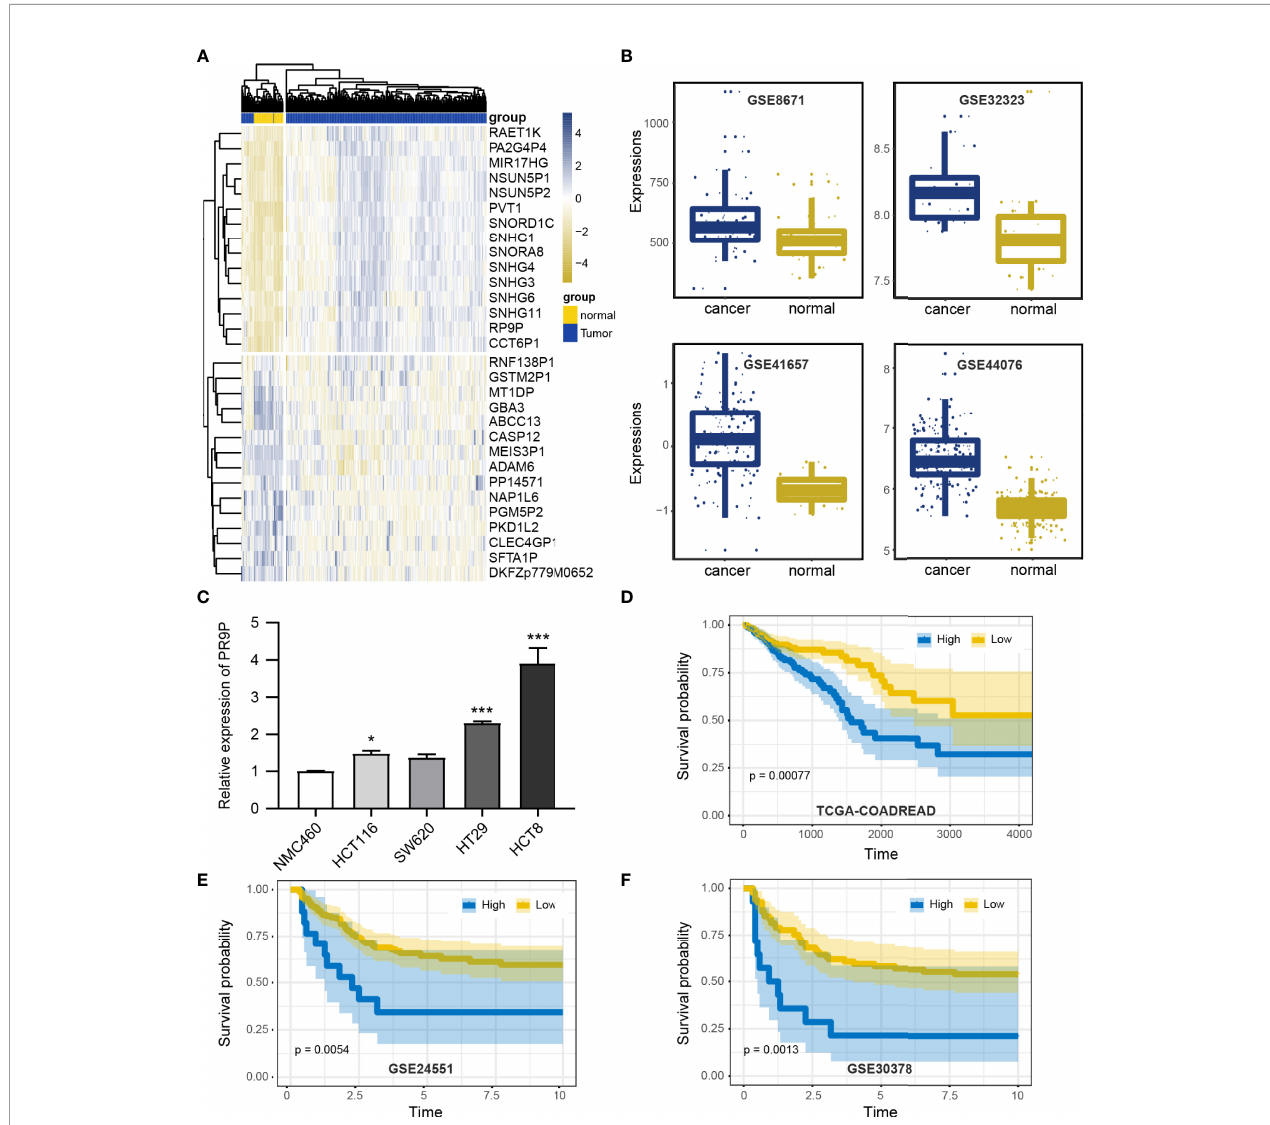
FIGURE 1 | Expression of RP9P in colorectal cancer (CRC) based on The Cancer Genome Atlas (TCGA) database. (A) Heat map of different lncRNA expression levels in CRC detected using TCGA-COADREAD data. (B) RP9P level in CRC tissues compared with normal CRC tissues detected using GSE32323, GSE41657, GSE44076, and GSE8671 data. (C) RP9P level in CRC cell lines (HCT116, SW620, HT29, and HCT8) compared with the NMC460 cell line (* p < 0.05, *** p < 0.001, vs. NMC460) (D – F) . Correlation of the RP9P level with overall survival in CRC patients using the Kaplan-Meier analysis from TCGA-COADREAD (D) , GSE24551 (E) , and GSE30378 (F)